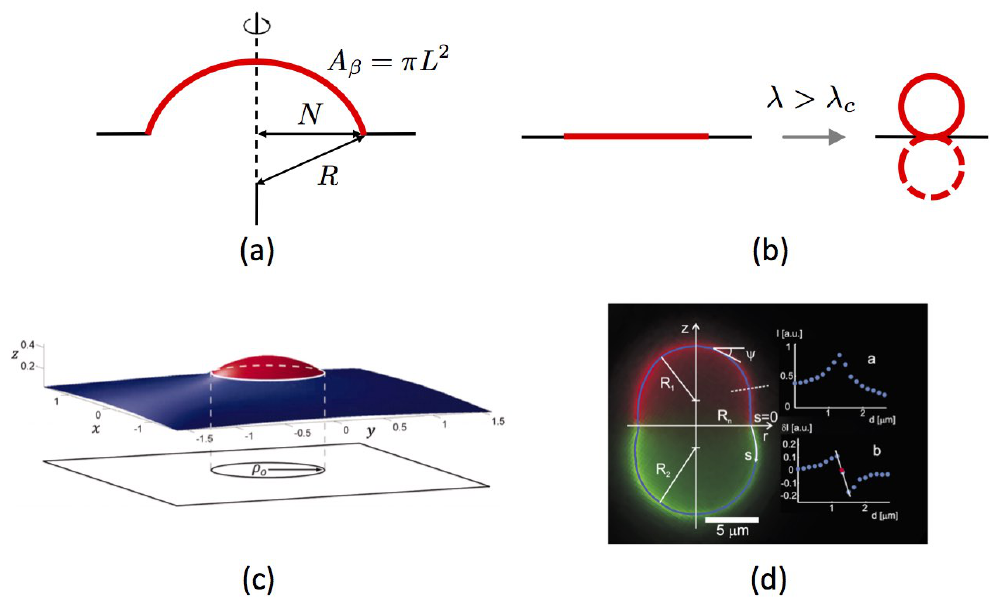
Figure 4. ( a ) In the case of plane tensionless membranes, a first approximation consists of considering spherical caps of Lo phase (or β phase, in red) of area A β = π L 2 in an otherwise infinite Ld membrane [110]; the spherical cap radius is denoted by R and the radius of the circle delimiting the phase boundary is N . ( b ) When the line tension λ exceeds a critical value λ c (Equation (18)), the previously planar domain buckles to a complete sphere in the tensionless case. Owing to the spontaneous symmetry breaking principle, the domain is equally likely to buckle upward or downward (up-down symmetry). ( c ) In a taut membrane with surface tension σ budding is incomplete. Reproduced from [107] with permission from the Proceedings of the National Academy of Sciences USA, Copyright 2009. ( d ) In the case of giant unilamellar vesicles (GUV), fluorescence microscopy experiments on ternary mixtures of 1,2-Dioleoyl-sn-glycero-3-phosphocholine (DOPC)/Sphingomyelin (SM)/cholesterol below the demixing temperature distinguishes the Lo and Ld phases appearing in red and green respectively. Mathematical modeling then enables the extraction of physical parameters such as bending moduli κ and line tension λ at the Lo/Ld interface. Reproduced from [106], with permission from the American Physical Society, Copyright